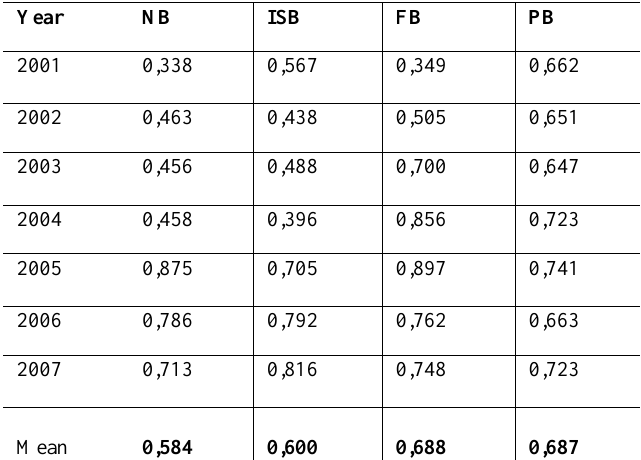
Table 6: Year-wise bank group level profit mean